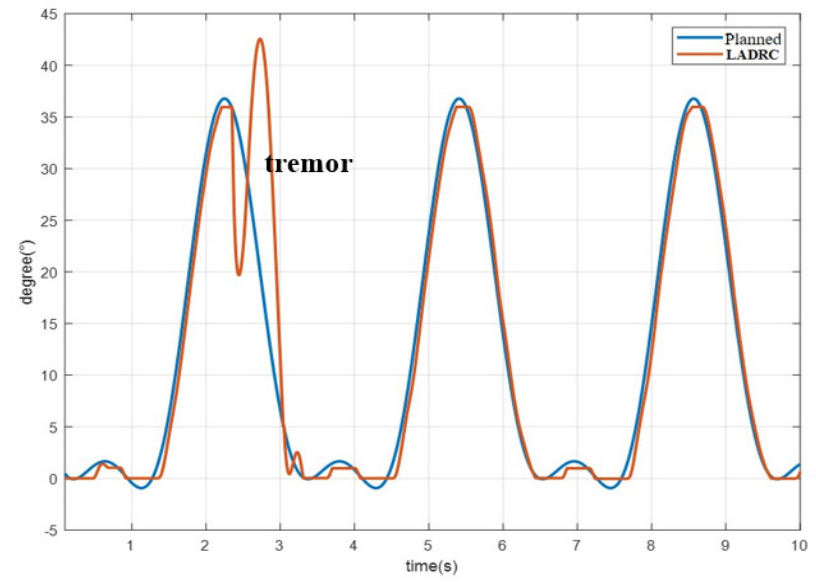
Figure 11. Trajectories of hip joint by LADRC with spasm and tremor occurring at walking speed = 0.15 m/s.